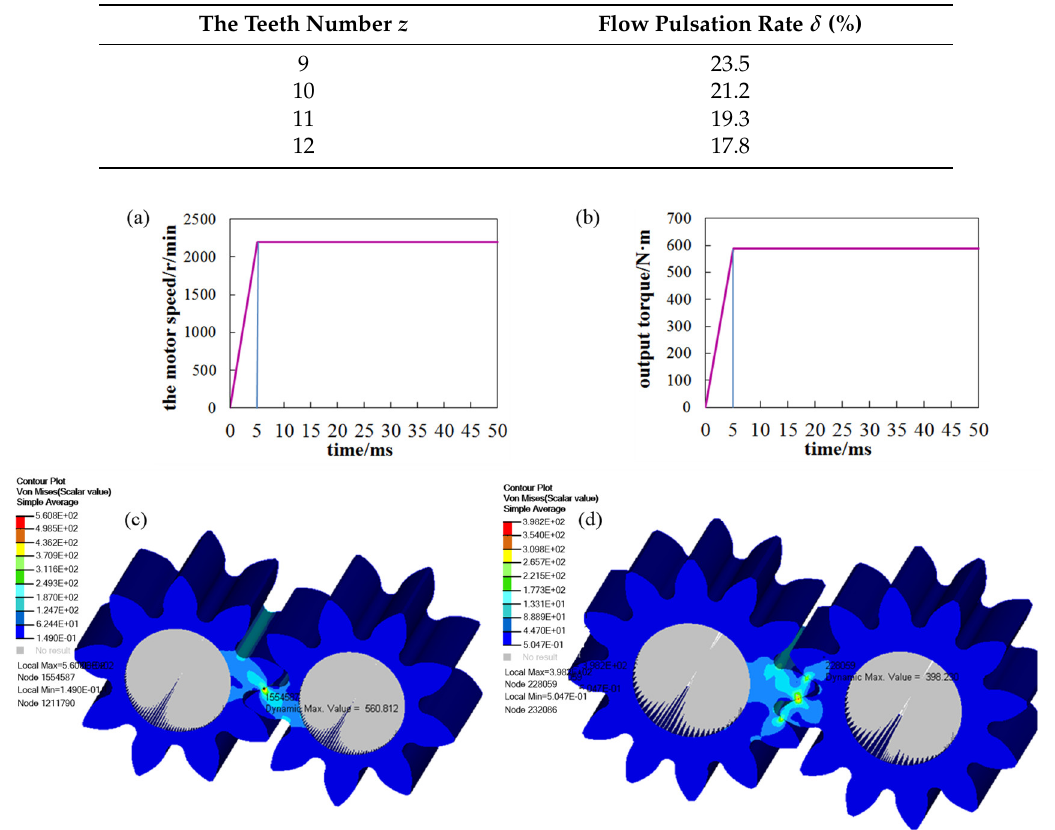
Table 2. The flow pulsation with different teeth numbers.